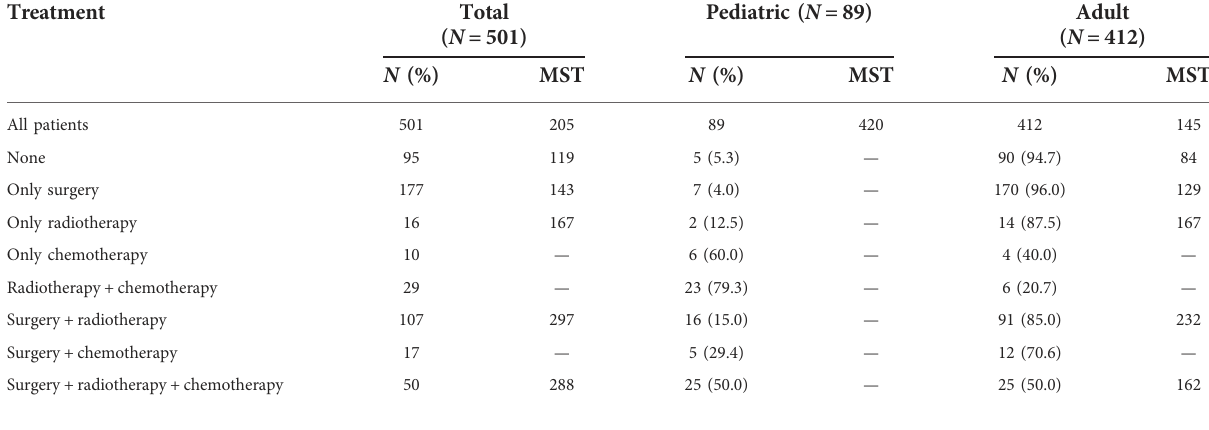
TABLE 3 Number and median survival time (MST) of patients with primary malignant pituitary tumors in different treatment groups. Treatment Total Pediatric ( N = 89) Adult ( N = 501) ( N = 412) N (%) MST N (%)